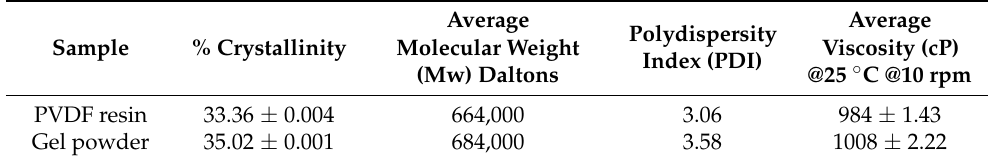
Table 1. Physical properties of the PVDF samples.